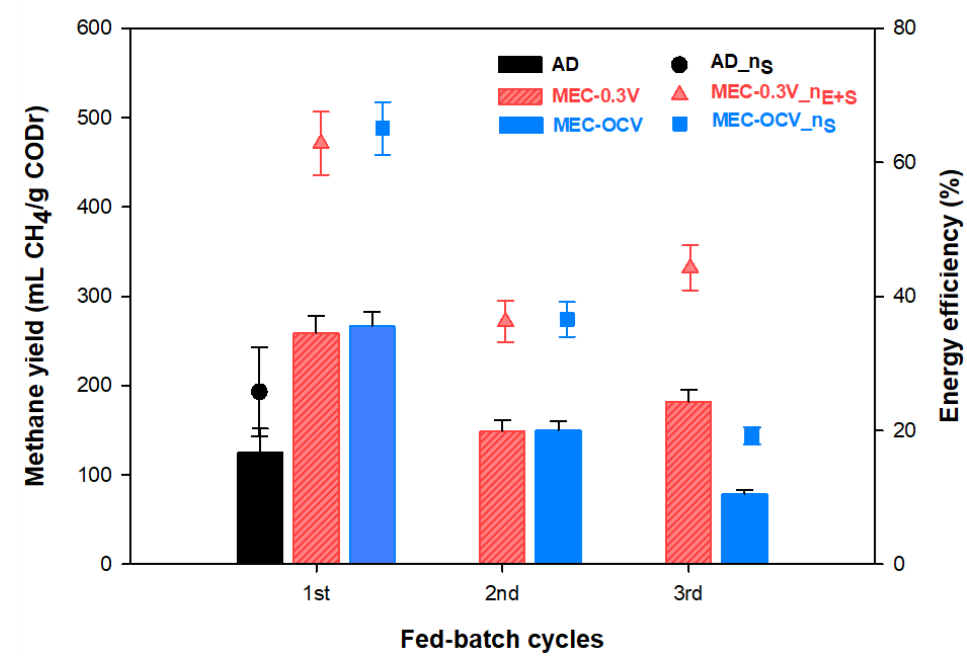
Figure 3. Methane yield and energy efficiency.